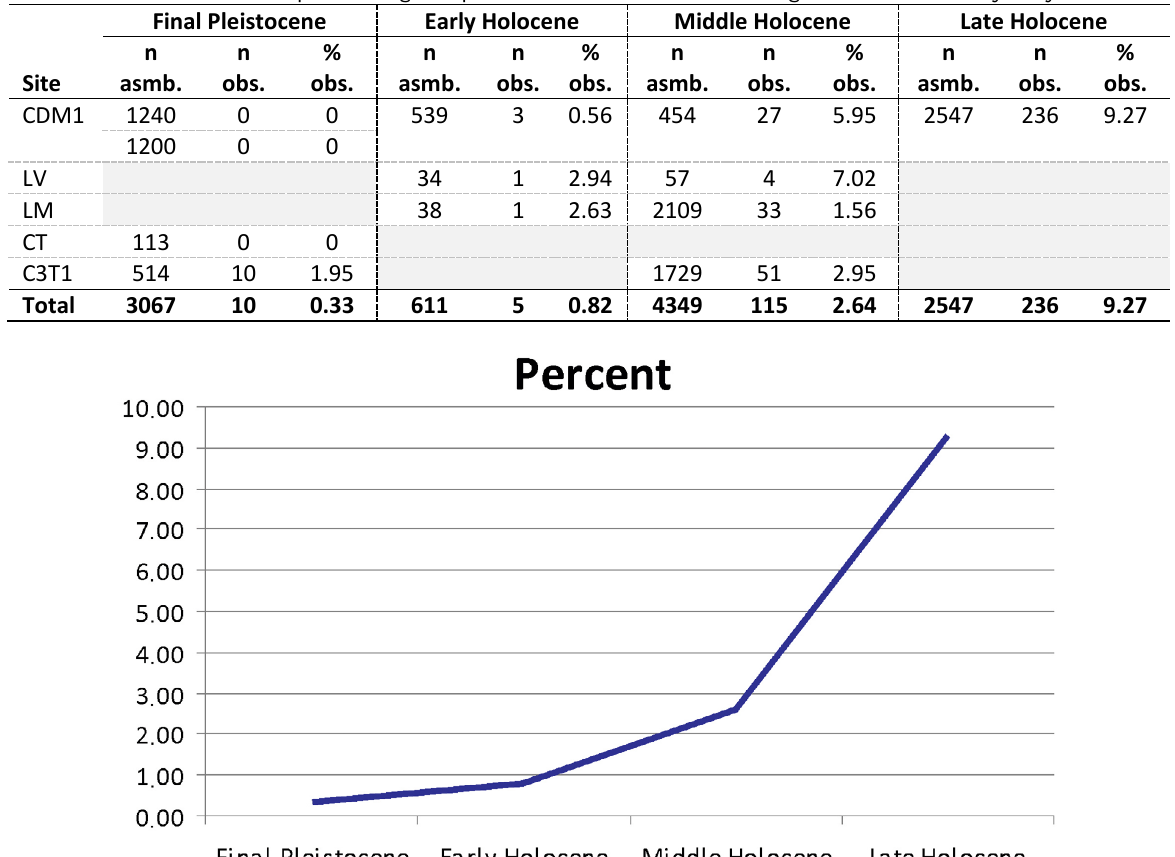
Table 2. Absolute frequency and proportion of obsidian in the analyzed assemblages. Abbreviations: n asmb. - total number of artifacts in the assemblage; n obs. - total number of obsidian artifacts in the assemblage. Empty cells - the site was not occupied during that period or that the lithic assemblage has not been analyzed yet.